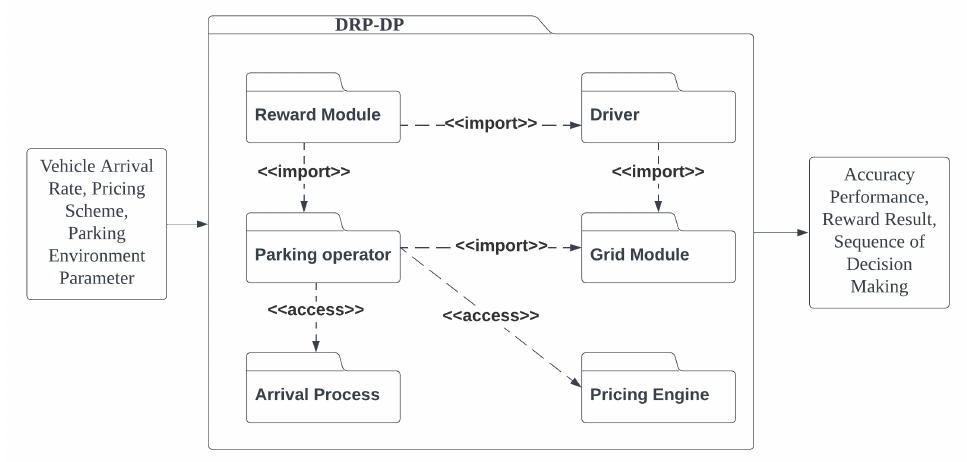
Figure 7. Relationship of module